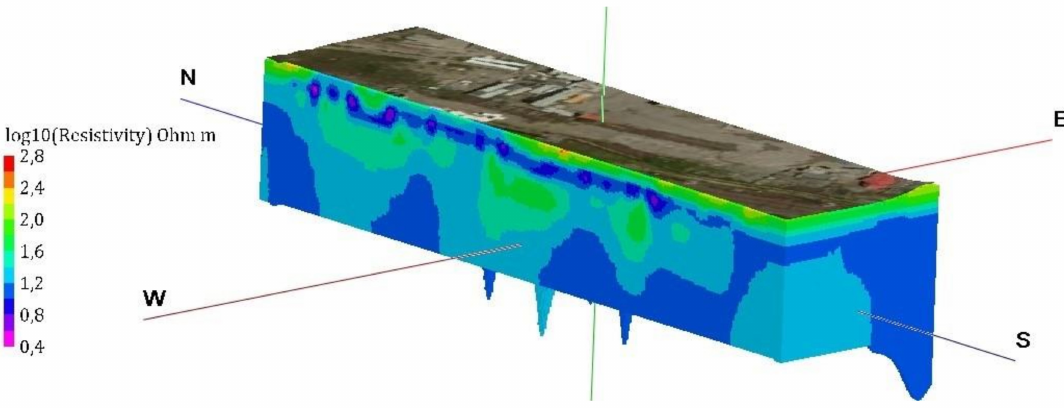
Figure 5. 3D resistivity model covering the pilot test